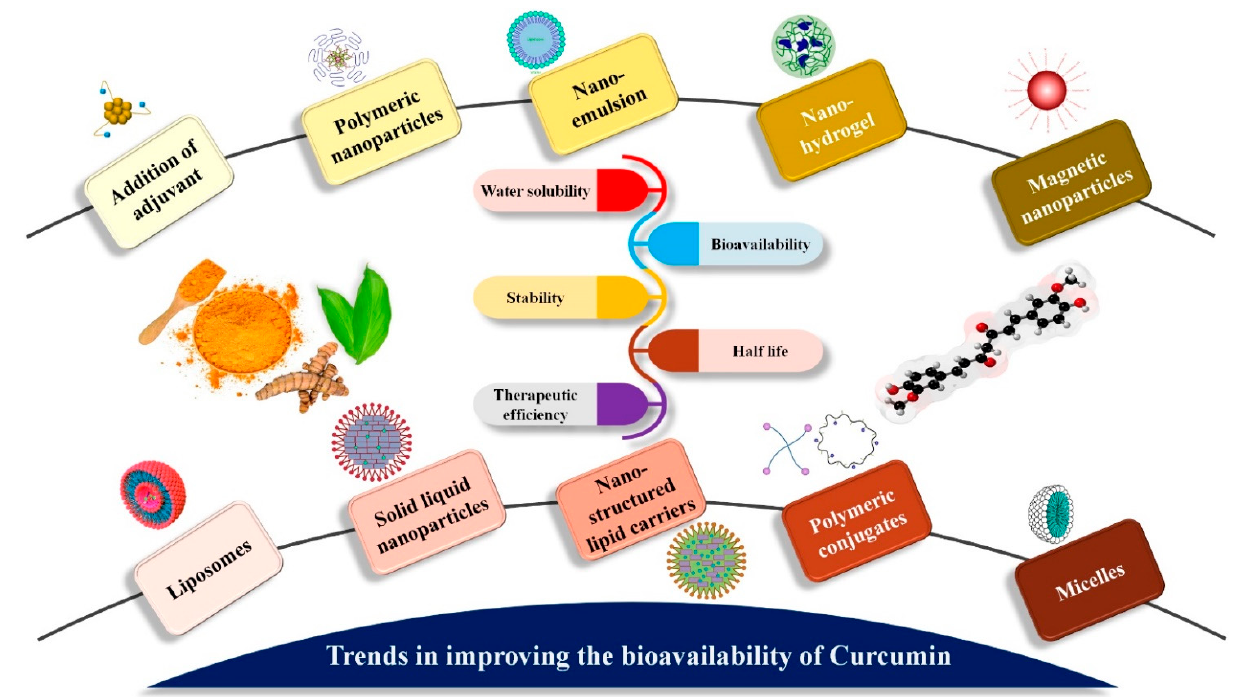
Figure 6. Trends in enhancing the oral bioavailability of curcumin. As shown in the image, various methods of nanotechnology have been used to enhance bioavailability of curcumin.